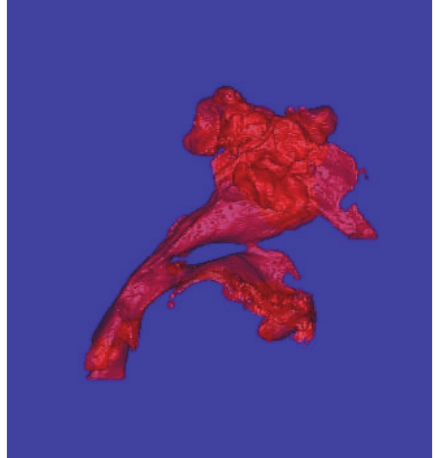
Figure 6: Three-dimensional computed tomography of the airway after surgery. The volume of theairway around thepharyngeal cavity is markedly increased compared with that before